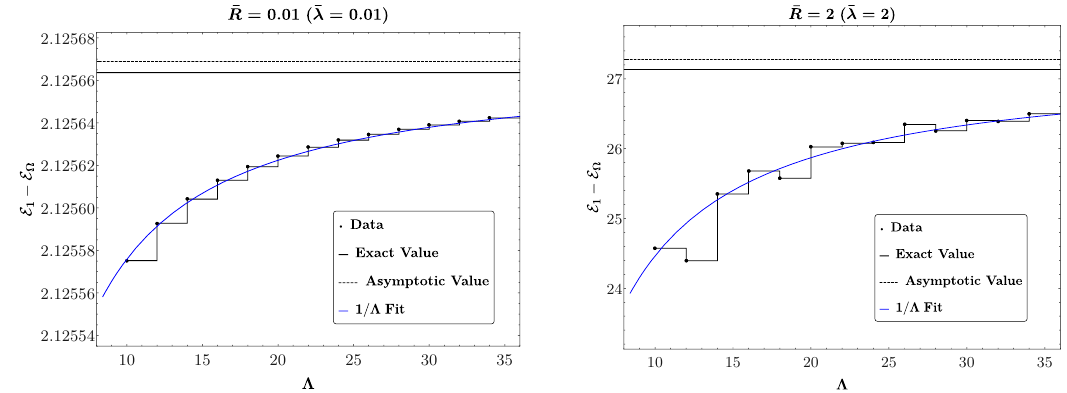
Figure 22. Energy of the first excited state in the Ising model deformed by (cid:15) versus the cutoff, for weak and strong couplings. The dashed lines are the asymptotic values extracted from the fit. The error bar can be found in figure